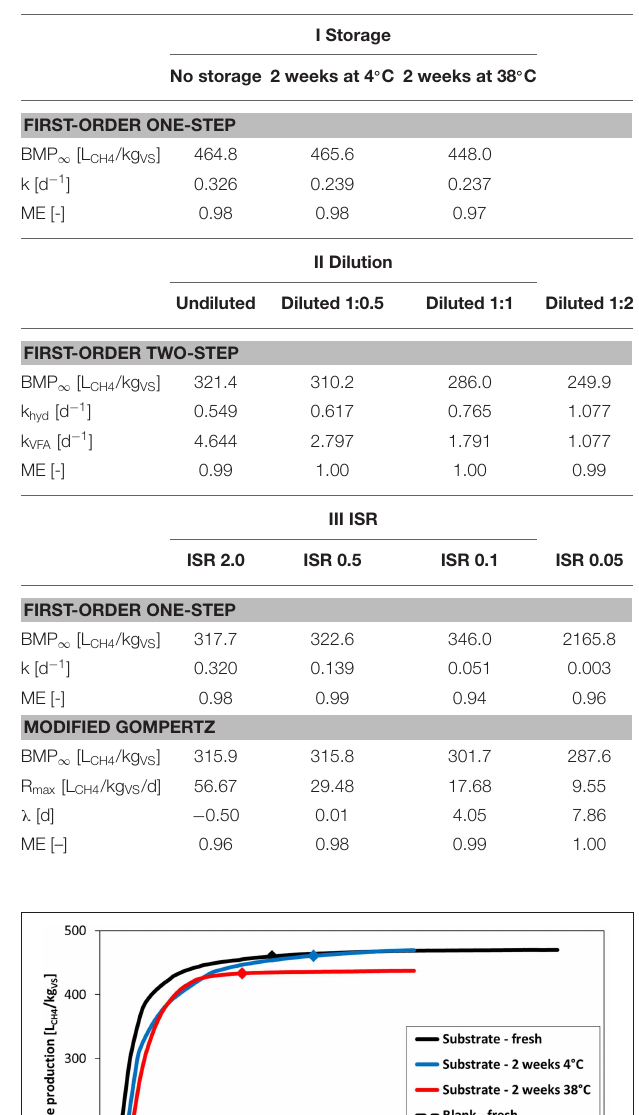
TABLE 3 | Parameter estimates for the kinetic models applied in the three experiments.